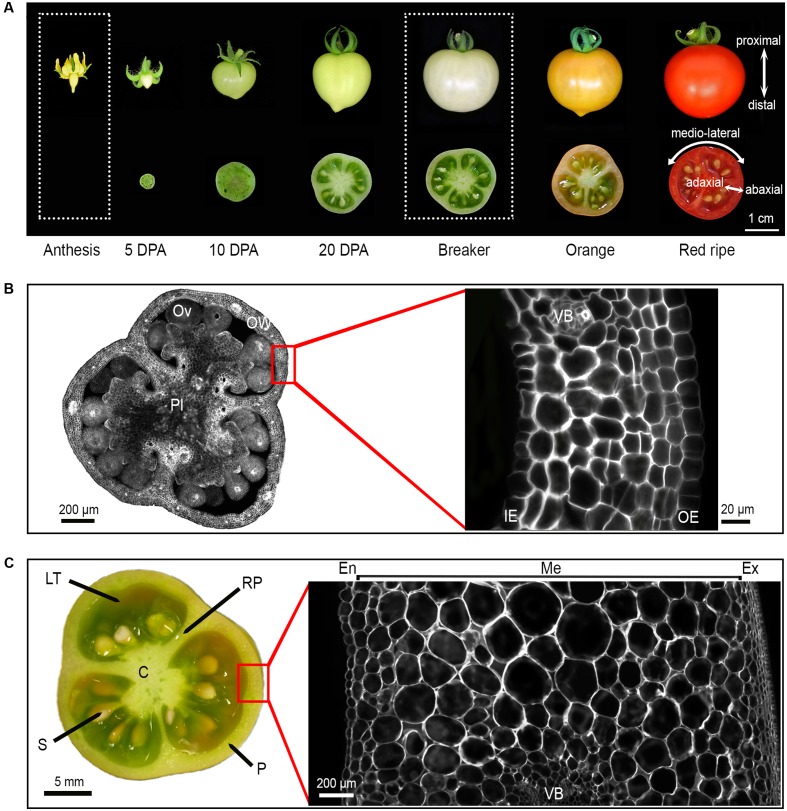
Tomato fruit development and tissue morphology in WT Micro-Tom cultivar. (A) Whole fruit and equatorial fruit sections from anthesis to red-ripe stage. The axes of growth: proximal to distal, medio-lateral and abaxial to adaxial are reported. (B) Equatorial ovary section and ovary wall section at anthesis stained with calcofluor. (C) Equatorial fruit section and pericarp section at breaker stage stained with calcofluor. DPA, Day Post Anthesis; OW, ovary wall; Pl, placenta; Ov, ovule; OE, outer epidermis; IE, inner epidermis, VB, vascular bundle; C, columella; LT, locular tissue; S, seed; RP, radial pericarp; P, pericarp; En, endocarp; Me, mesocarp; Ex, exocarp.